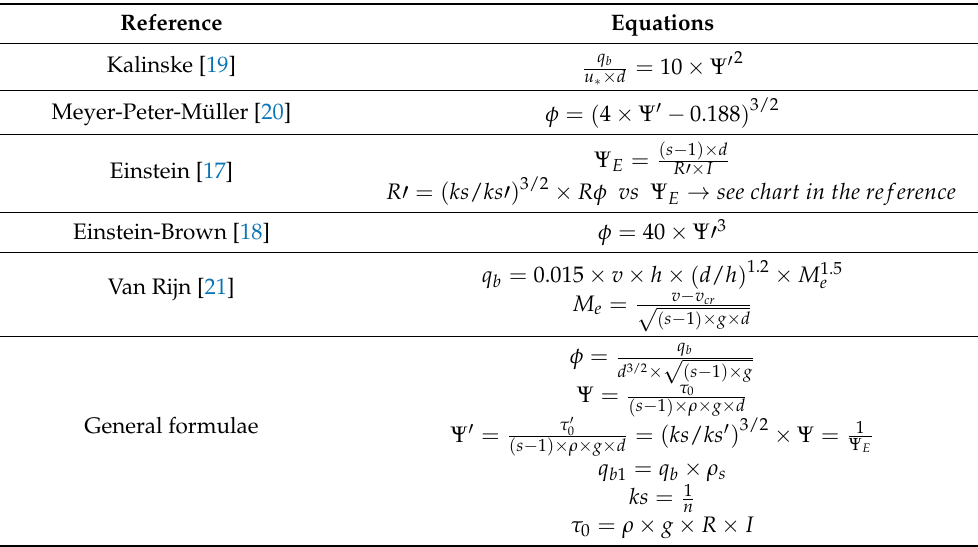
Table 2. Empirical formulae applied to estimate bedload transport